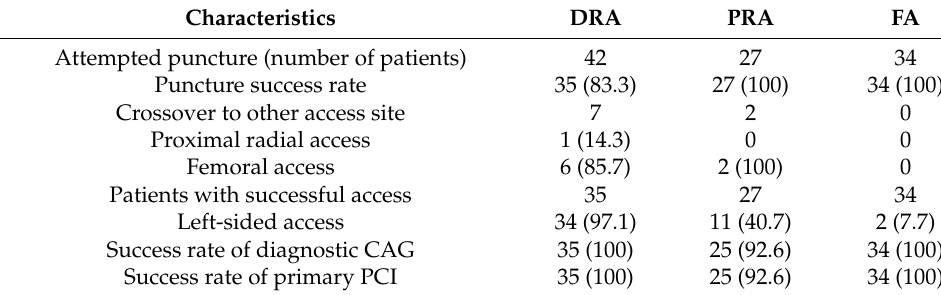
Table 1. Detailed information regarding vascular access routes.